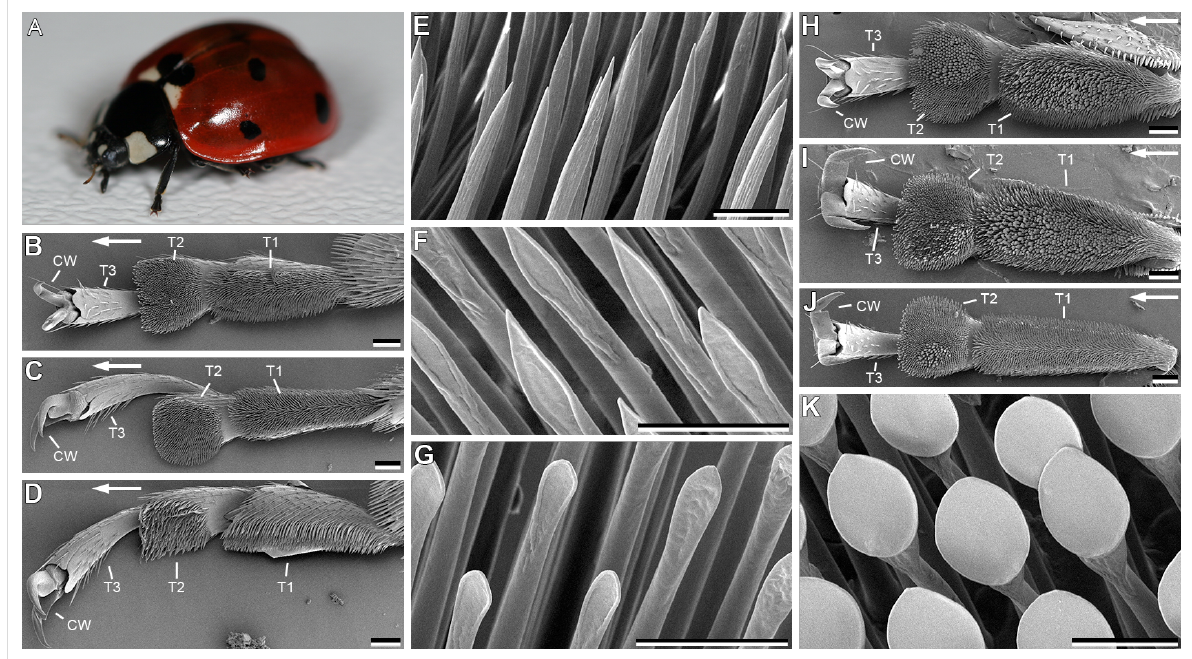
Figure 1: Attachment devices of Coccinella septempuctata (A) attachment devices. Tarsi of forelegs (B), midlegs (C), and hindlegs (D) in females are ventrally covered by different types of tenent setae (E–G). Tarsi of forelegs (H), midlegs (I), and hindlegs (J) in males. Tarsi of males were also ventrally covered by tenet setae types shown in (E, F), but have an additional type, which is terminated with discoidal terminal elements (K). CW, claws; T1, first proximal tarsomer; T2, second proximal tarsomer; T3, third proximal tarsomer. The arrows in (B–D) and (H–J) indicate distal direction. Scale bars in (B–D, H–J), 100 µm. Scale bars in (E–G, K), 10